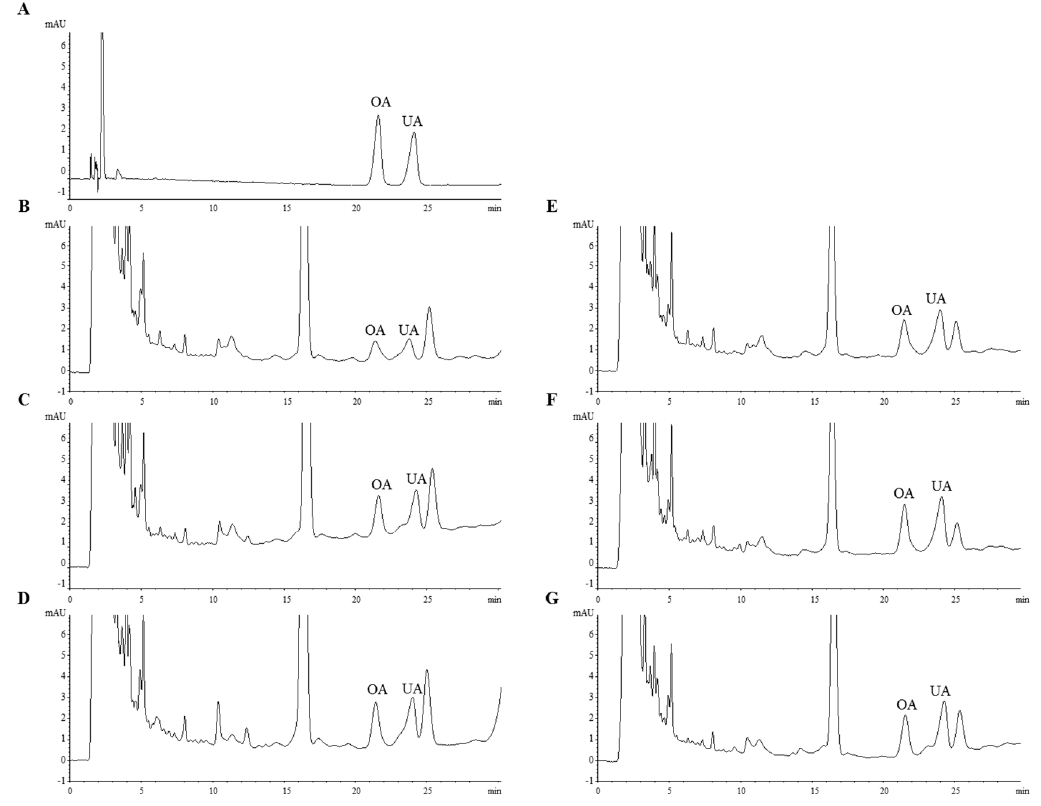
Figure 4. HPLC chromatograms (210 nm) of oleanolic acid (OA) and ursolic acid (UA) from S. plebeia ( A ): two triterpenoid standards; ( B ): 2 months; ( C ): 3 months; ( D ): 4 months; ( E ): 5 months; ( F ): 6 months; ( G ): 7 months. Table 4. Oleanolic acid and ursolic acid content in S. plebeia at the different growing periods. Samples